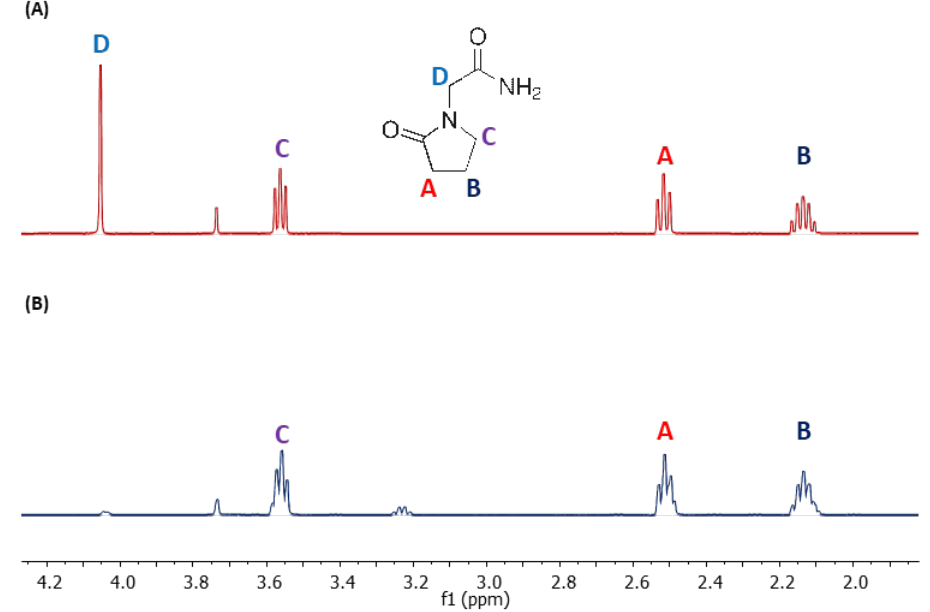
Figure 2. 1 H NMR spectrum of ( A ) piracetam in D 2 O and ( B ) piracetam after 72 h incubation in the mixture of 1% N,N,N-triethylamine solution in D 2 O, lyophilisation and redissolving in D 2 O. The letter designations of the carbons correspond to the signals marked with these letters in the NMR spectrum.